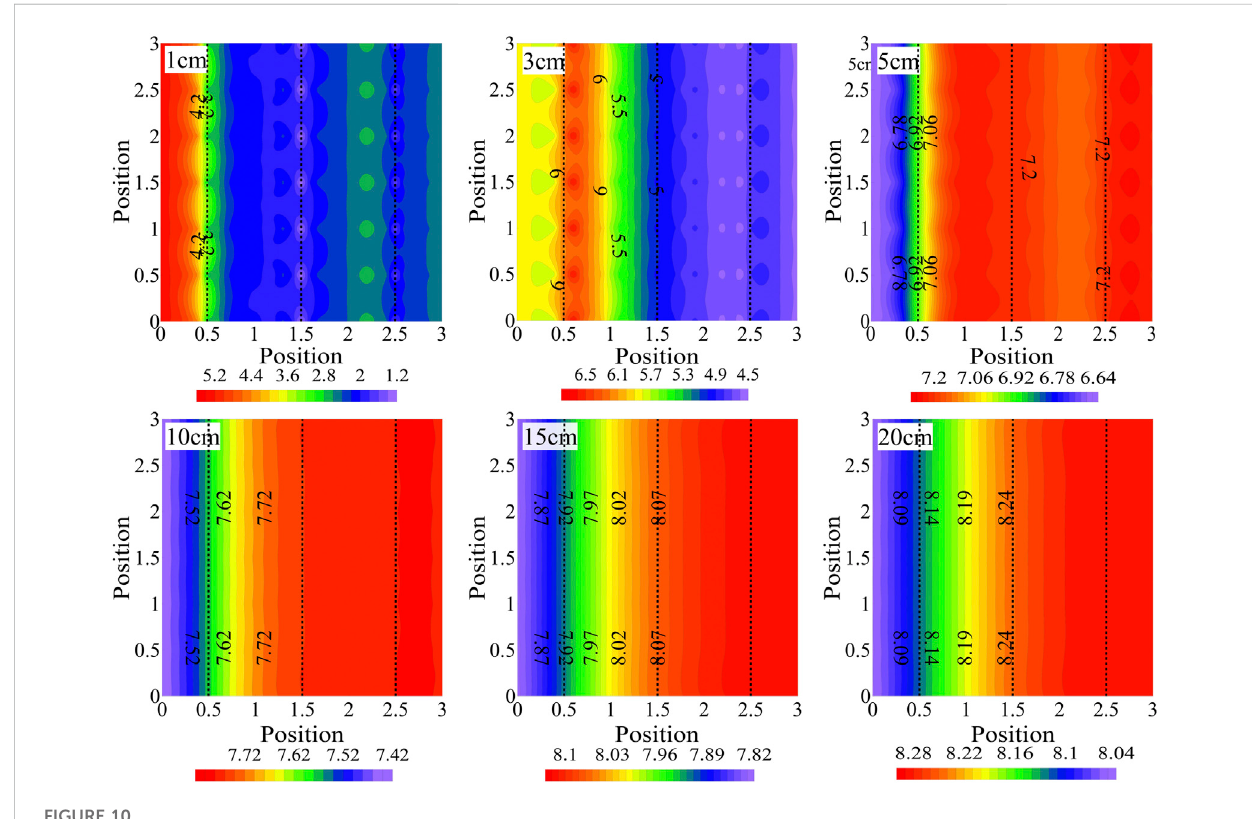
FIGURE 10 Horizontal wind velocity pro fi le speed around parallel sand